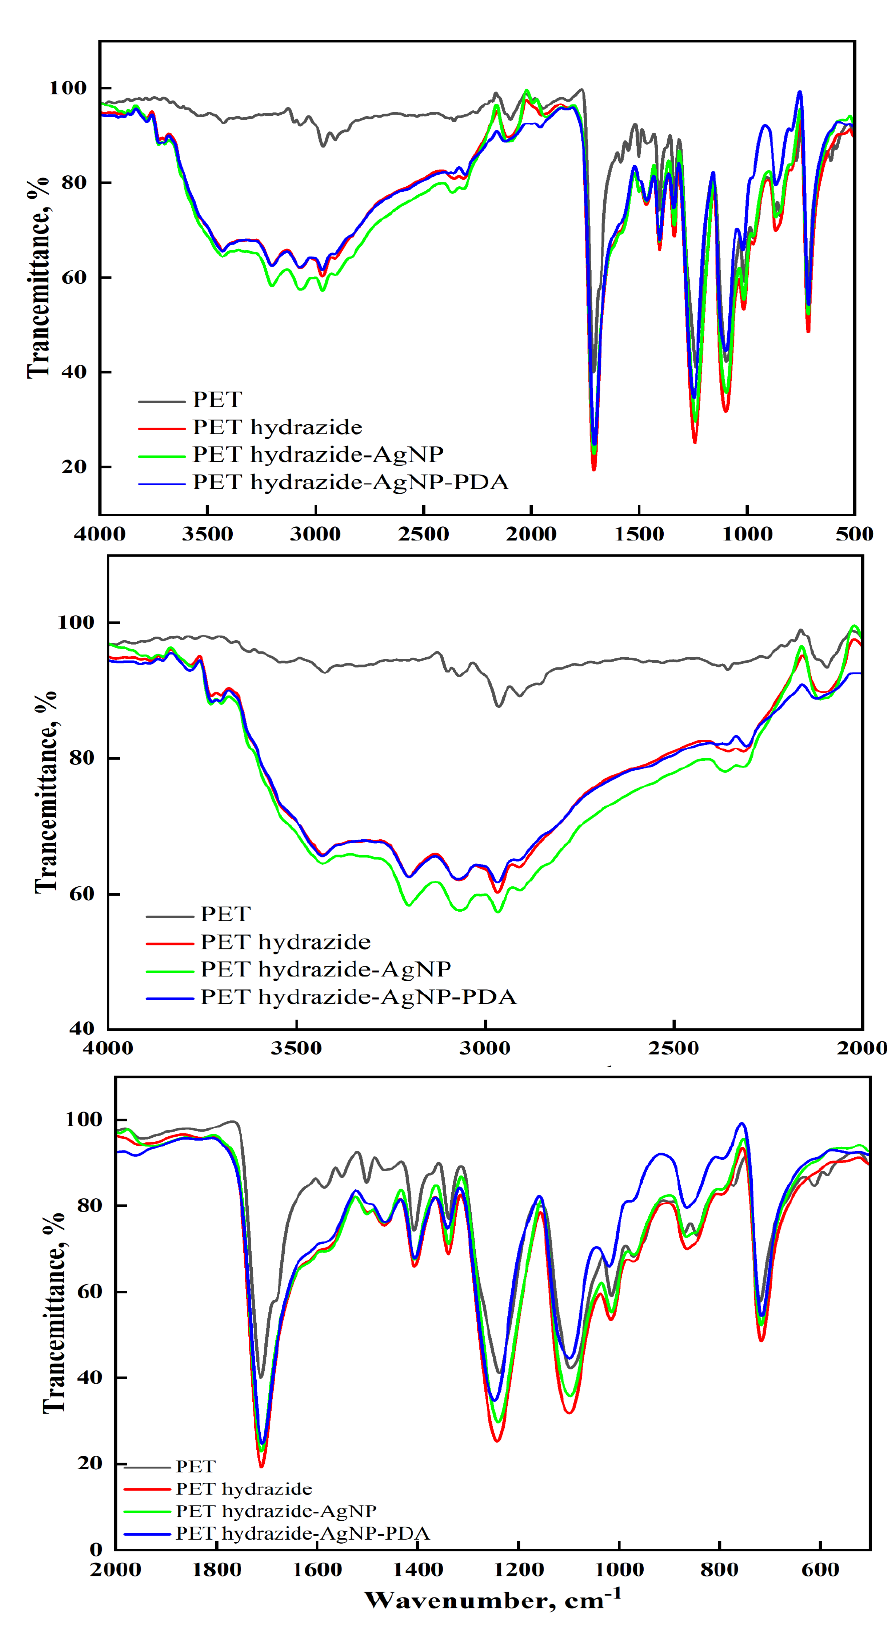
Figure 3. ATR-FTIR spectra of PET, PET hydrazide, PET hydrazide-AgNP, and PET hydrazide-